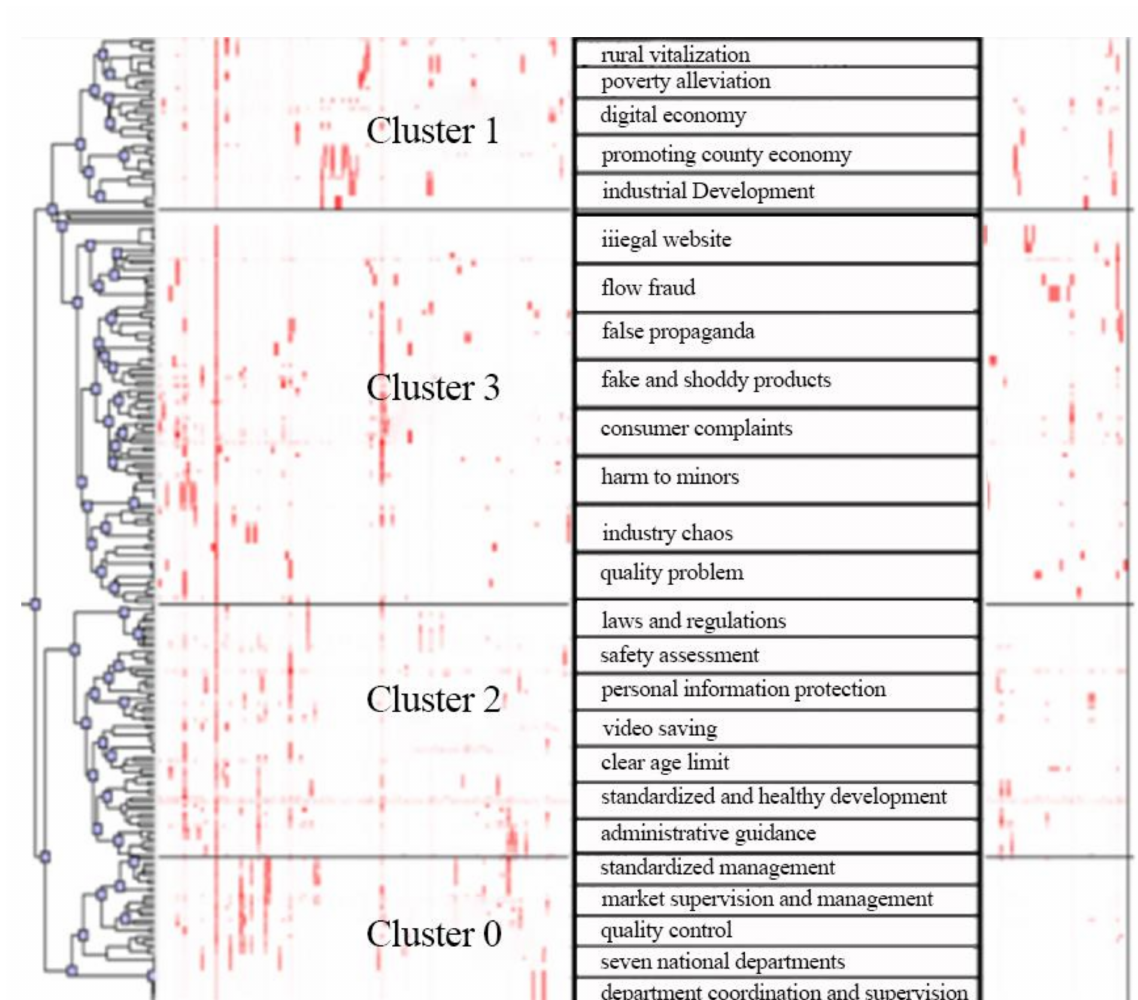
Figure 3. Mountain map.